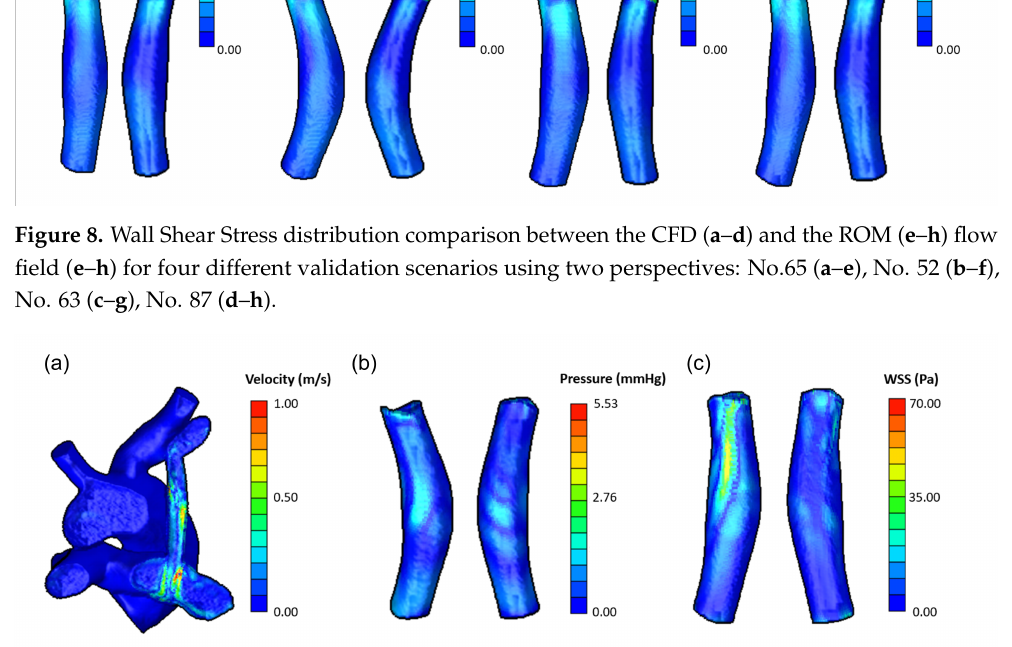
Figure 9. Maximumabsolute error of the velocity in scenario No. 34 ( a ), pressure in scenario No. 101 ( b ), and wall-shear stress in scenario No. 87 ( c )